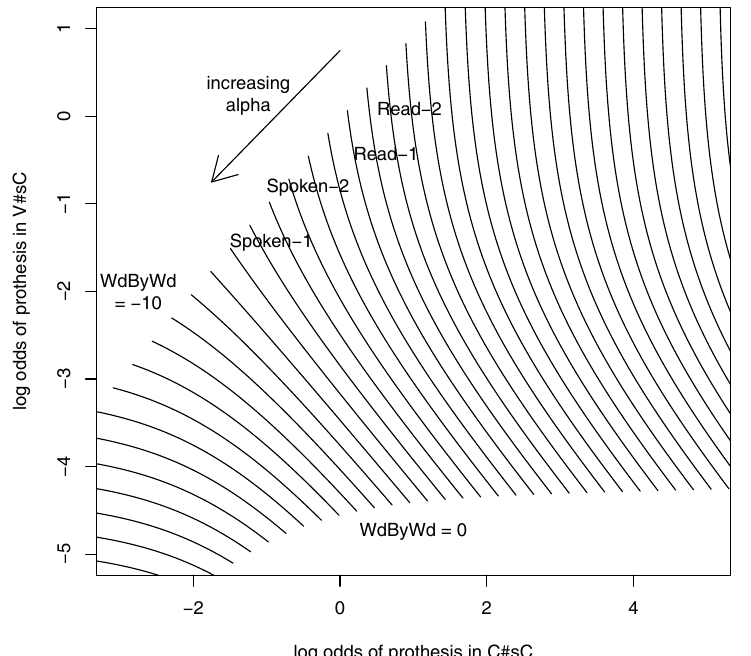
Figure 6 . Predicted log-odds of prothesis in C#sC vs. V#sC contexts as a function of interpolation coefficient and ‘effort’ constraint